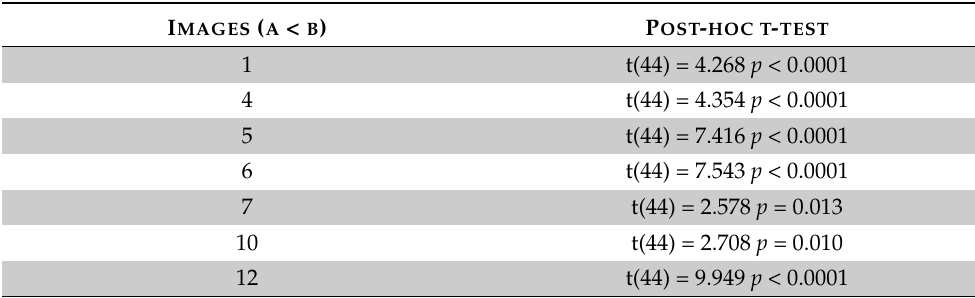
Table 2. Post-hoc t-tests for images with different dynamicity, headless bodies (B) more dynamic than bodiless heads (A).